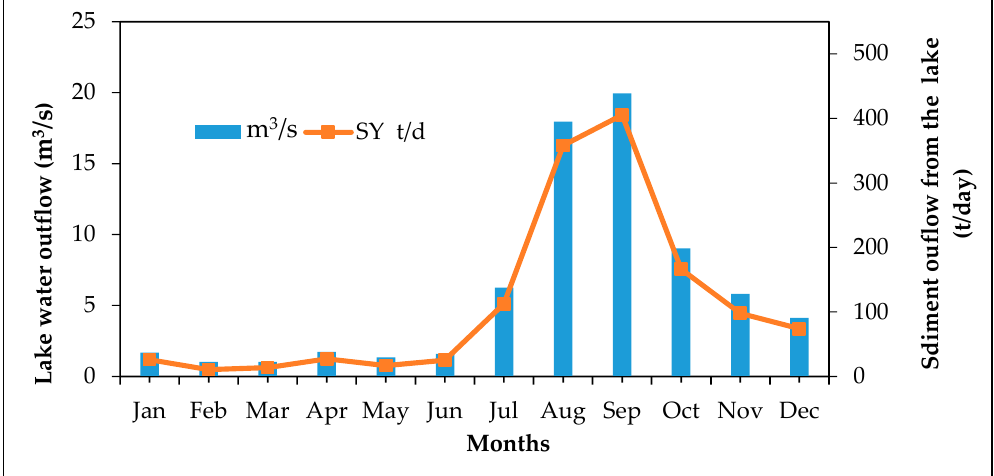
Figure 9. Suspended sediment concentration (SSC) and lake outlets.